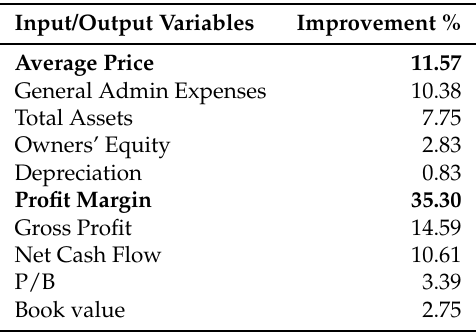
Table 3. Total potential improvements.